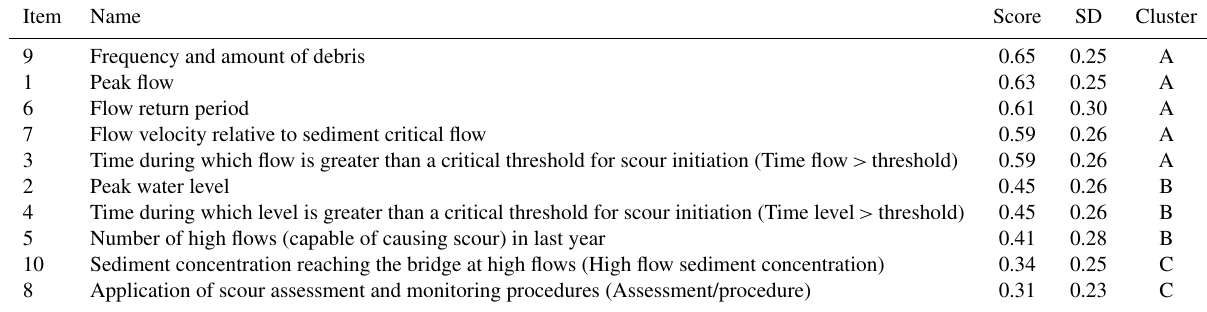
Table 4. Ranking scores for factors according to their relevance in defining the loading condition for a scour fragility